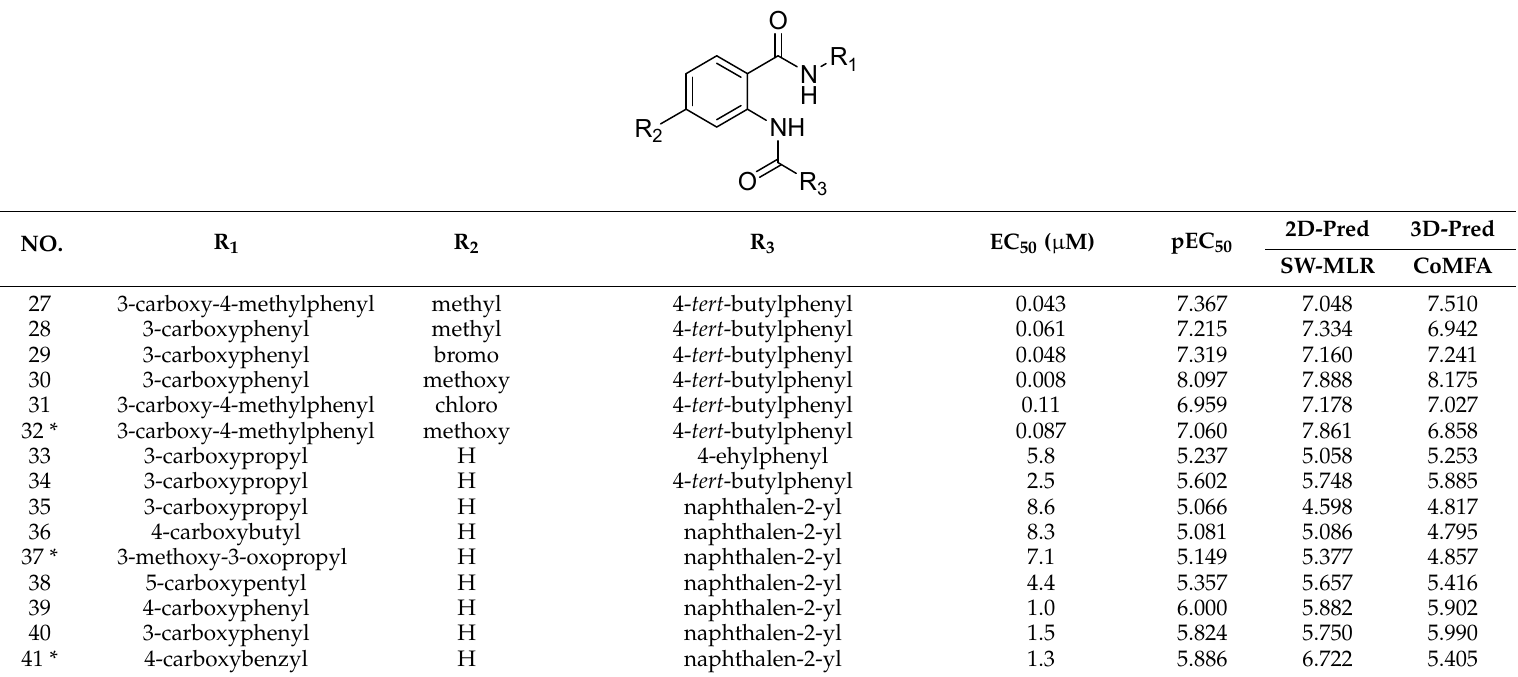
Table 3. Molecular structures and corresponding experimental and predicted pEC 50 values of the AAD as partial FXR